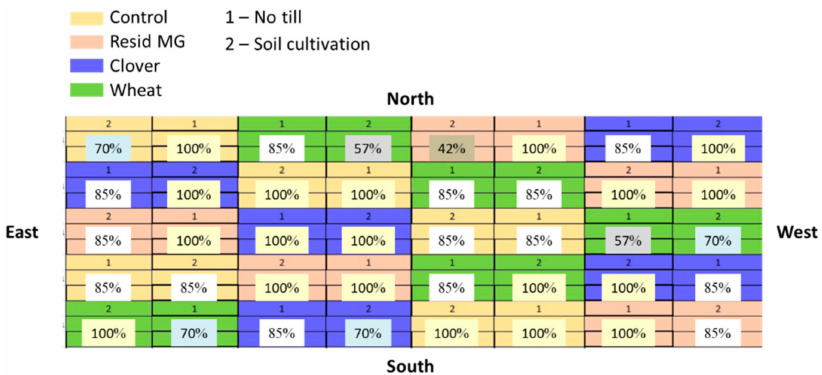
Figure 2. The field experiment map and maize emergence percentages. An LWD-contaminated field (Gadash Experimental Farm, Upper Galilee, Hula Valley, Northern Israel) was used to evaluate the winter crop (clover or wheat) and tillage system on disease severity and pathogen population in the hyper-susceptible Megaton cv. The treatments were compared to a commercial Resid MG treatment (arbuscular mycorrhiza soil enrichment) and non-cropped soil (the soil left bare throughout the winter). A split-plot design was applied, whereby (1) indicates no-till cropping and (2) traditional soil cultivation (tillage). Each treatment/control was repeated five times and the plots were scattered in the field using a completely randomized design. Above ground sprouts’ emergence percentages were stated six days after sowing (DAS) and indicated for each plot.